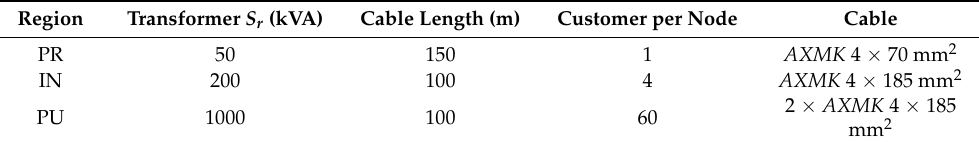
Table 2. Low Voltage (LV) grid component parameters for domestic